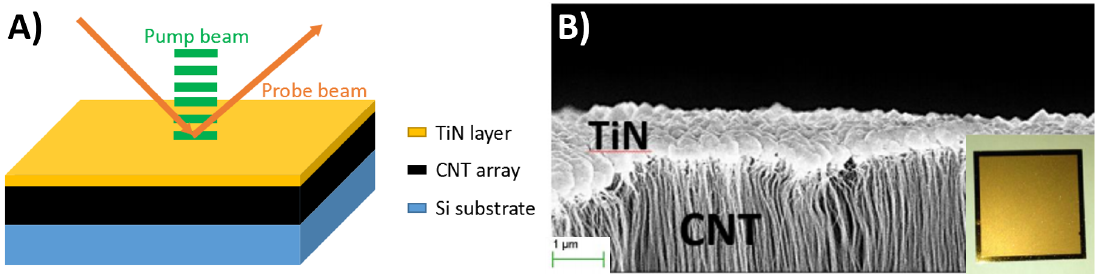
Figure 4. ( A ) Schematic illustration of the three-layer PPR measurement; and ( B ) SEM image of the CNT covered Si samples after sputtering of TiN [15].